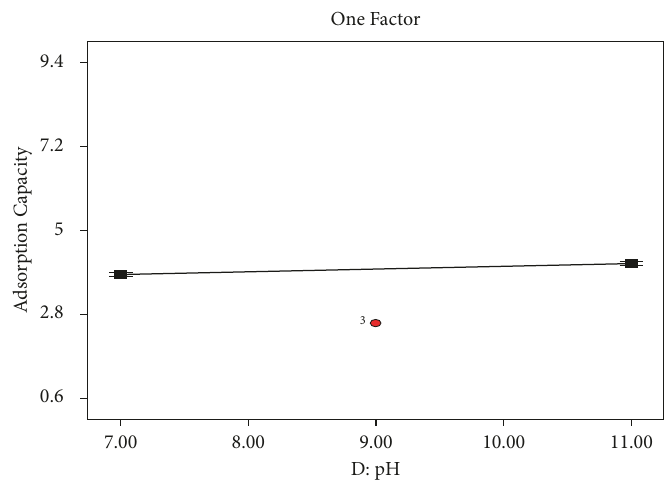
Figure 5: The Effect of pH on the Adsorption Capacity of MB.